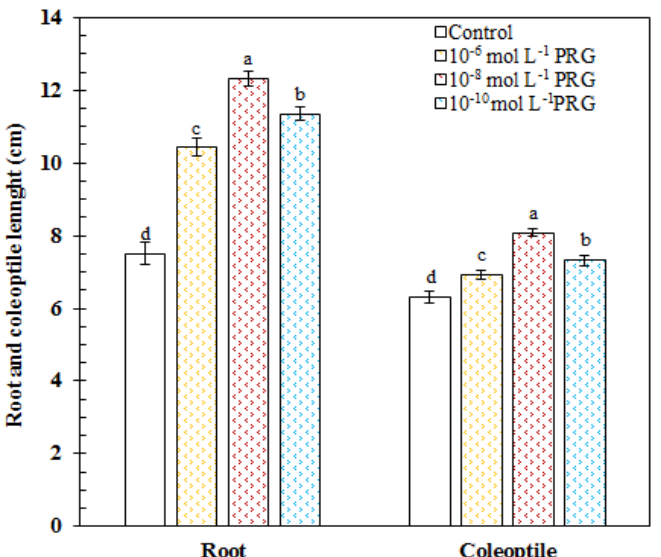
Figure 1. Effects of progesterone applications on root and coleoptile lengths of 4-day-old maize seedlings.